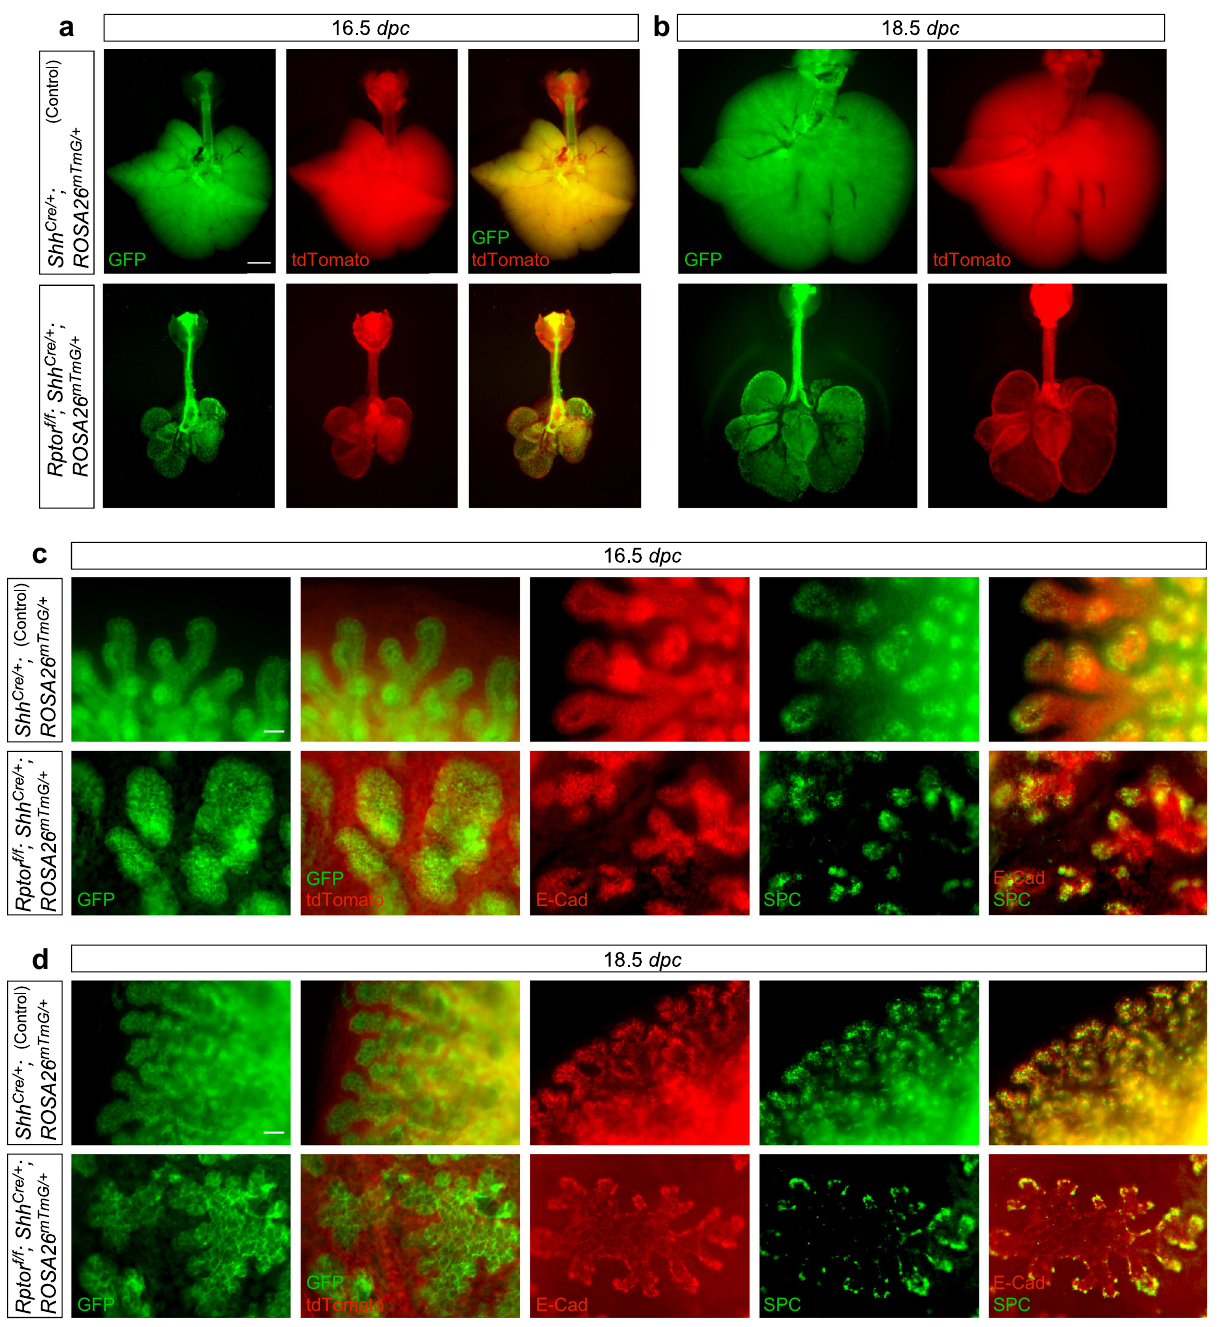
Fig. 3 | Loss of Rptor does not disrupt saccule formation. a , b Whole-lung imaging of dissected lungs from Shh Cre/+ ;ROSA26 mTmG/ + (control)and Rptor f/f ; Shh Cre/+ ;ROSA26 mTmG/ + mice at16.5and 18.5 days post coitus ( dpc ).GFP was acti- vatedfromthe ROSA26 mTmG allele inalllungepithelialcellsby Shh Cre ;tdTomato marked allnon-epithelialcells. ManyGFP + dots were present onthe surface of Rptor f/f ;Shh Cre/+ ;ROSA26 mTmG/ + lungs.Scalebar= 1mm. c Highermagni fi cationof whole-lungimagingandwhole-mountimmunostainingofdissectedlungsfrom Shh Cre/+ ;ROSA26 mTmG/ + and Rptor f/f ;Shh Cre/+ ;ROSA26 mTmG/ + miceat16.5 dpc .GFPand E-Cadherin(E-Cad)labeled allepithelialcells,while SPC (SFTPC)marked alveolar epithelialtypeII (AT2)cells located atthe tipsof saccules.ManyGFP +